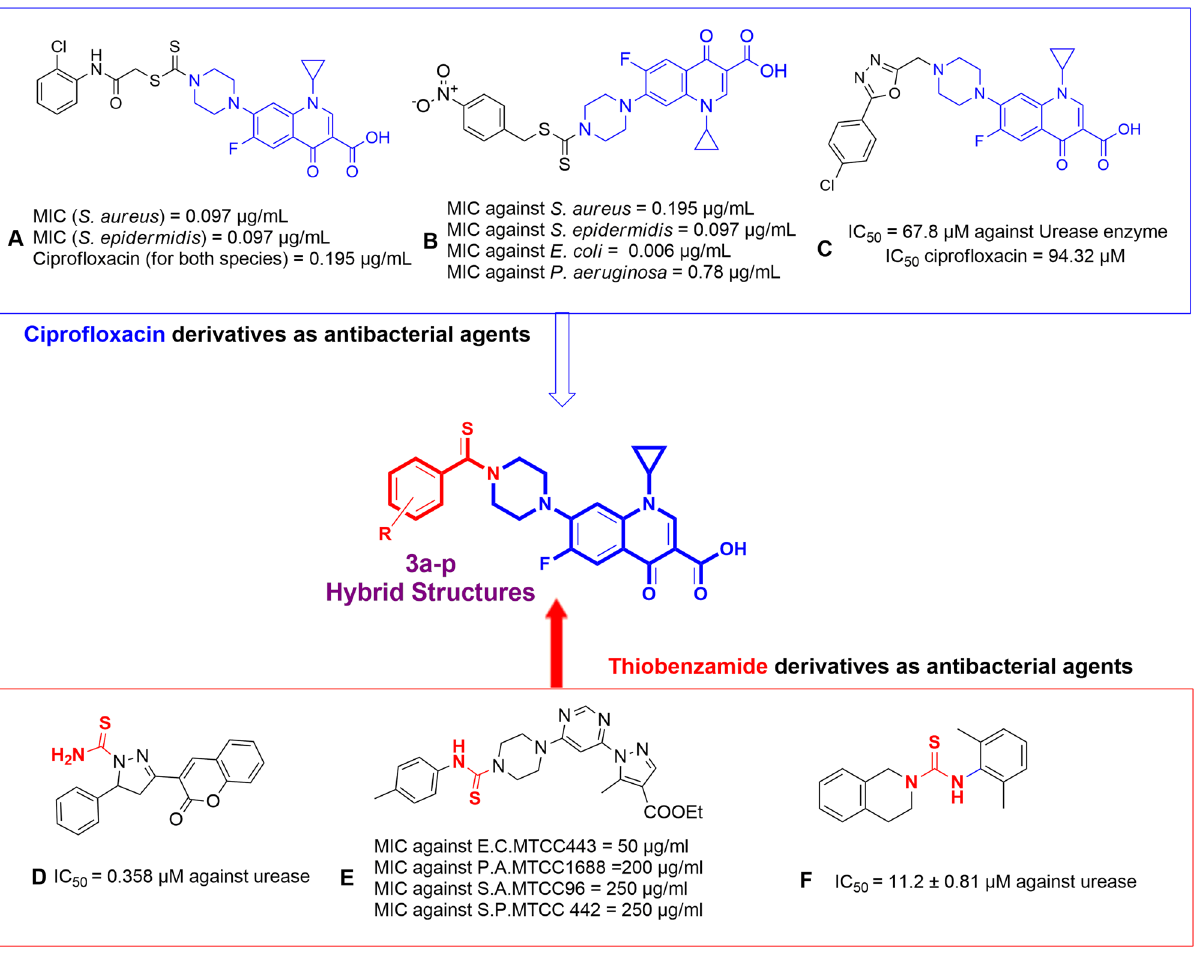
Figure 1. Identified representative lead